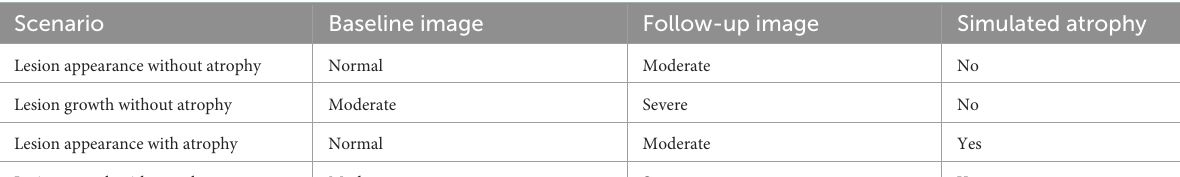
TABLE 1 Simulated longitudinal acquisitions.